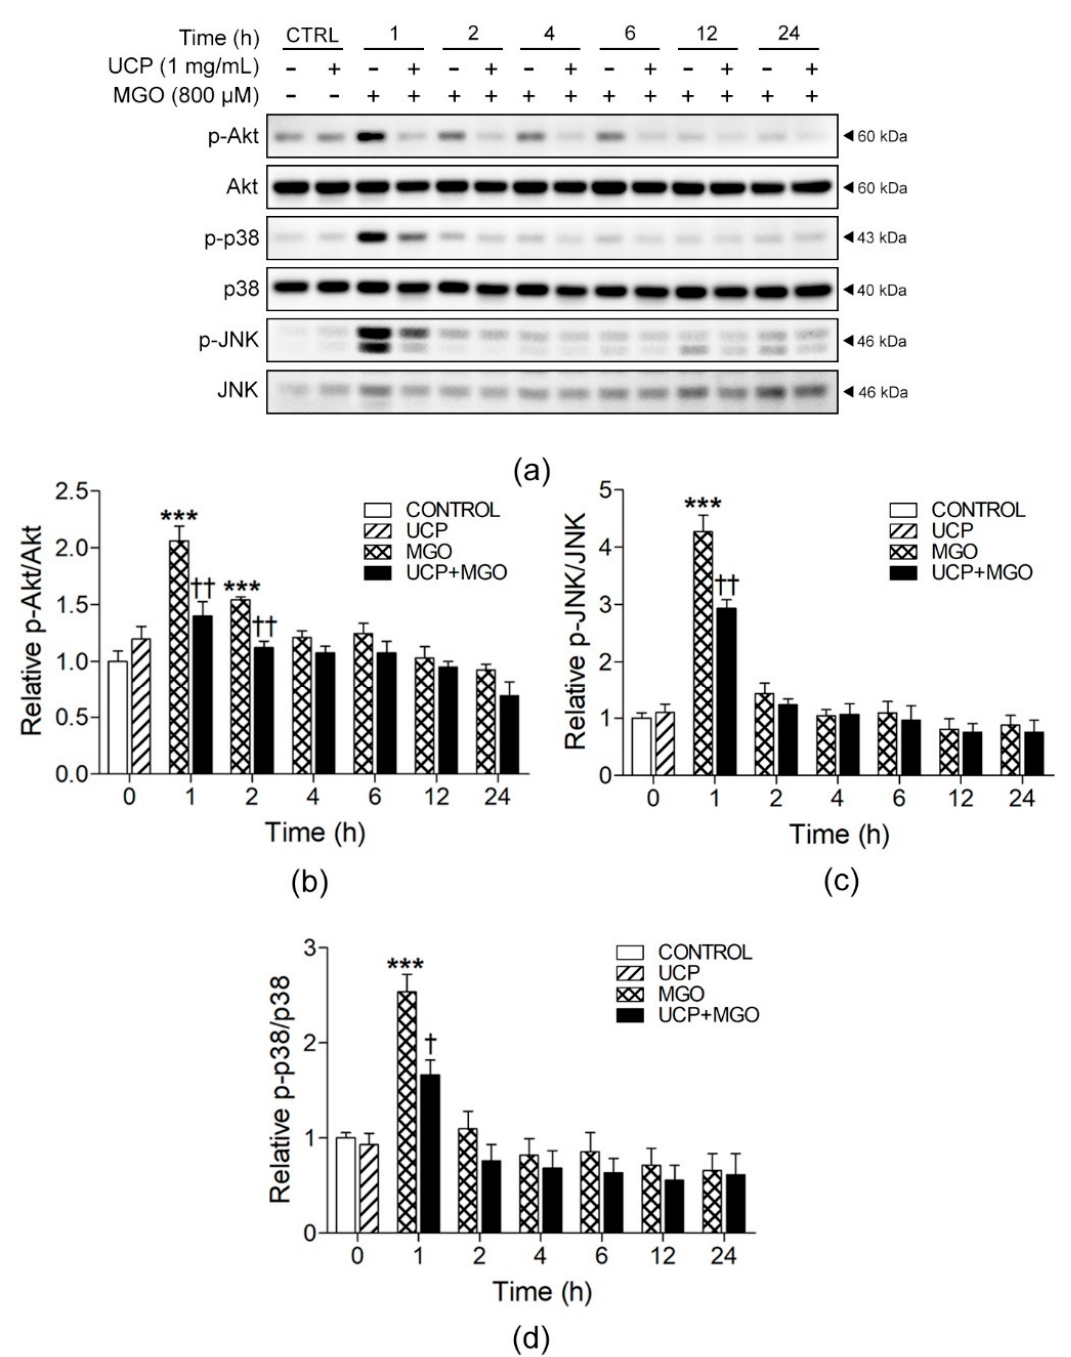
Figure 7. Effects of UCP pre-treatment on MGO-induced cell survival and cell death pathways. ( a ) Representative Western blot protein bands. Relative ratios of ( b ) p-Akt/Akt, ( c ) p-JNK/JNK, and ( d ) p-p38/p38. Data are presented as mean ± SEM. ***, p < 0.001, when compared with each treated group; †, p < 0.05 and ††, p < 0.01, when compared MGO-exposed group at the same time point.